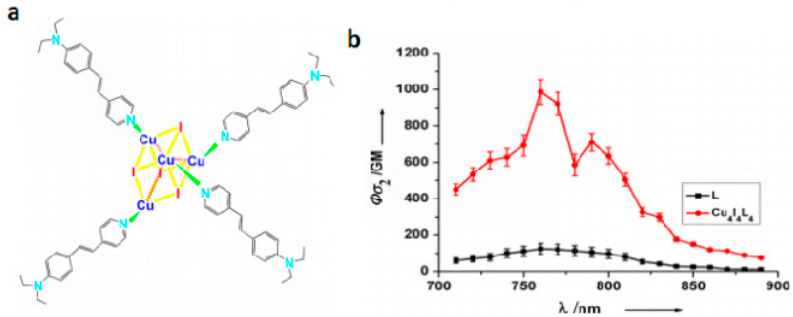
Figure 26. ( a ) Molecular structures of Cu 4 I 4 L 4 ( 99 ); ( b ) Two-photon absorption action spectra of L and Cu 4 I 4 L 4 ( 99 ) in ethanol ( c = 1.0 × 10 − 4 mol·L − 1 ).